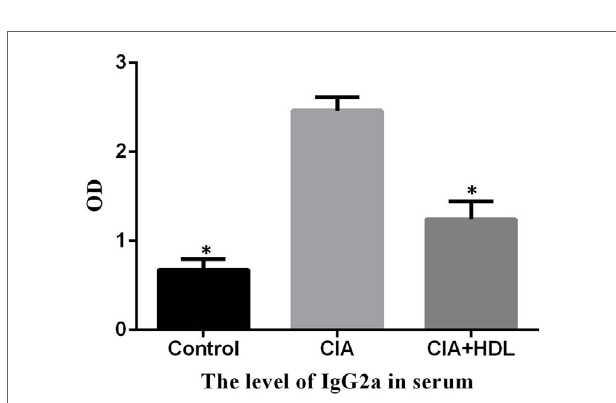
FigUre 3 | The serum level of anti-collagen-II IgG2a. Compared with the collagen-induced arthritis (CIA) group, the level of IgG2a in CIA + high- density lipoprotein (HDL) group were significantly lower than that of CIA (* p < 0.05 vs.